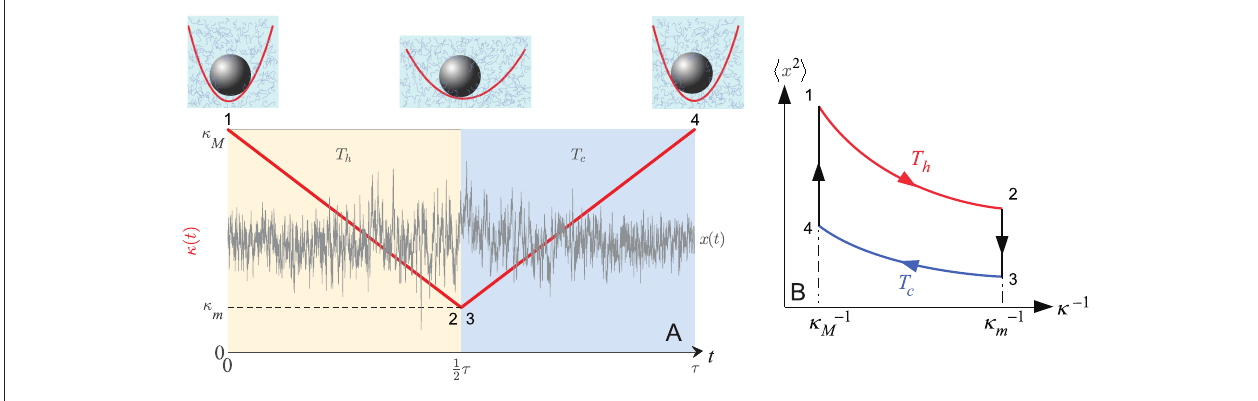
t < τ/ 2, the trap stiffness is ≤ τ/ 2, the temperature is 2). At t → = 4). The cycle is →